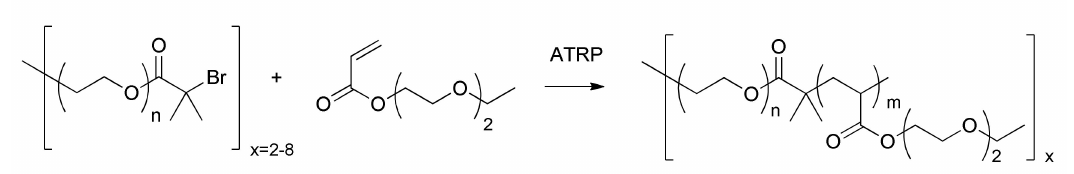
Figure 1. Synthesis of the thermoresponsive block polymers.